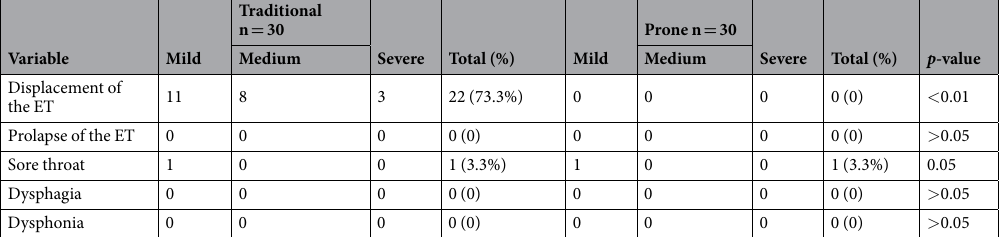
Table 2. Incidence of intraoperative or postoperative complication in patients before leaving the post- anesthesia care unit (PACU). Mild: < 0.5 cm; Medium: 0.5–1.5 cm; Severe: > 1.5 cm, ET: Endotracheal